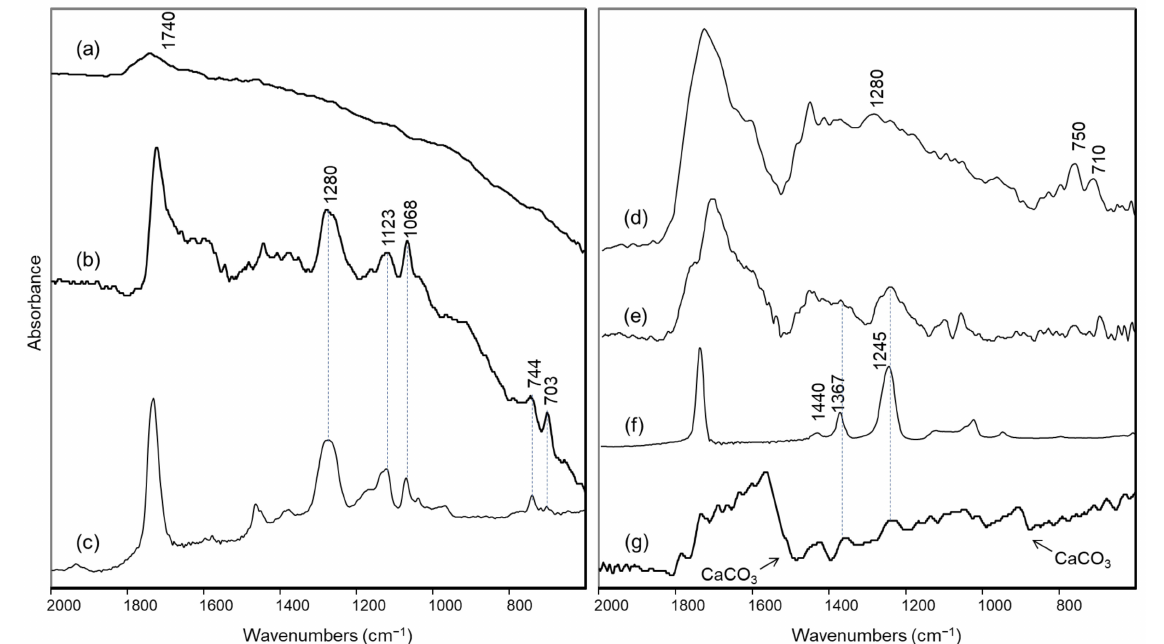
Figure 2. FTIR specular reflection spectra of areas on the front of the “Concetto spaziale”: ( a ) silver paint (Area 1); ( b ) black spot in an empty space of the silver paint (Area 2); ( c ) reference alkyd resin spread on canvas; ( d ) yellowish spot corresponding to an accumulation of binder (Area 3); ( e ) differential spectrum between spectra ( b , d ); ( f ) reference polyvinyl acetate spread on canvas; ( g ) possible retouching in the upper left corner of the painting (Area 4). In all cases the spectra shown were obtained from the experimental reflectance data using the Kramers–Kronig transform, with the exception of spectrum ( d ), which was obtained from a transparent material superimposed on the metallic surface, and is thus shown as pseudo-absorbance, log(1/R). In spectrum ( g ), the bands due to calcium carbonate are distorted due to specular reflectance of a material with a higher particle